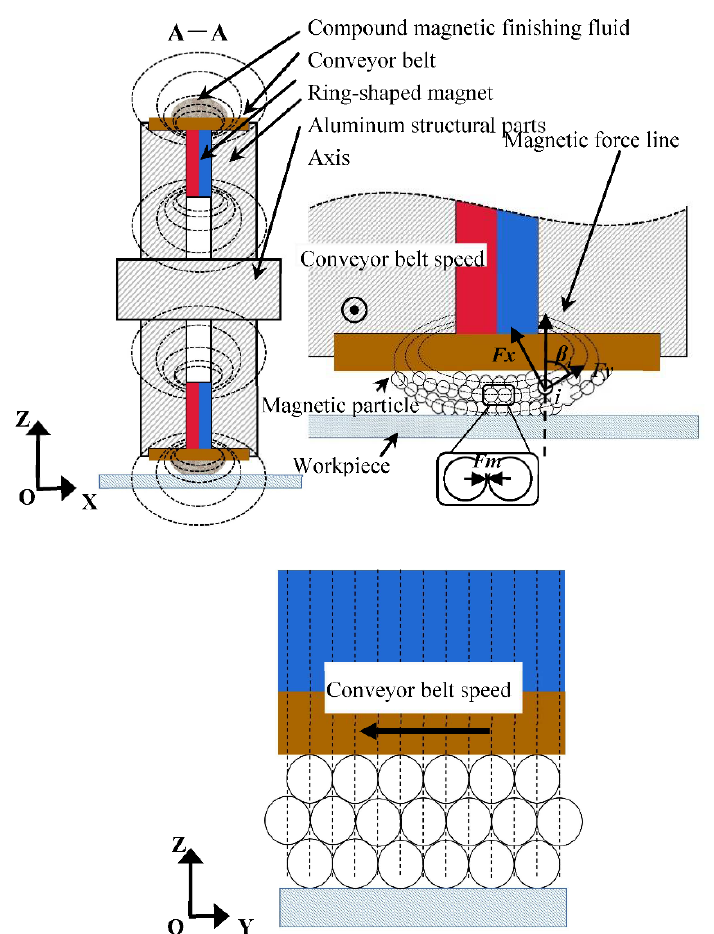
Figure 3. Sectional view and a partial enlarged view of the finishing wheel. Reprinted from Precision Engineering, 72, Xu J, Zou Y, Development of a new magnetic abrasive finishing process with renewable abrasive particles using the circulatory system, Pages No. 417-425, Copyright (2021), with permission from Elsevier.